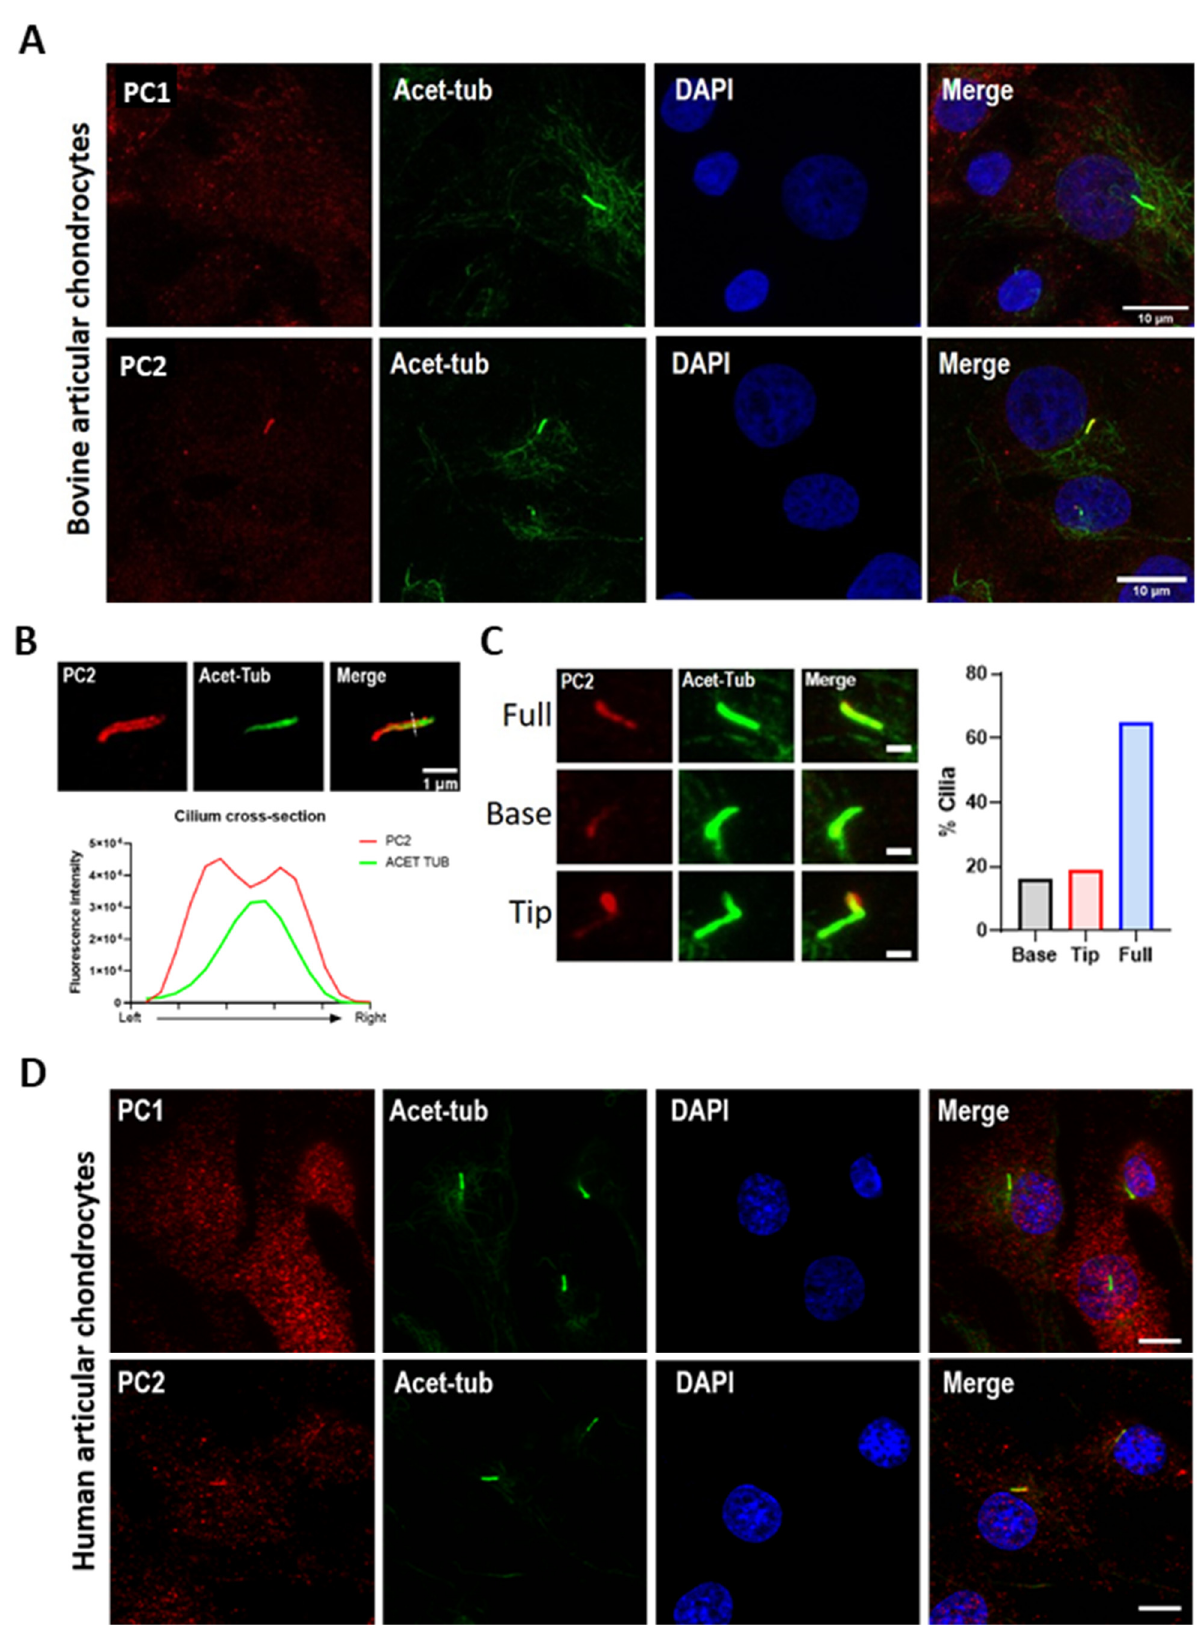
Figure 2. Polycystin-2 localizes to the chondrocyte primary cilium. ( A ) Primary bovine articular chondrocytes were immunolabeled for Polycystin-1 (PC1, red) or Polycystin-2 (PC2, red), primary cilia were labeled for acetylated tubulin (acet-tub,